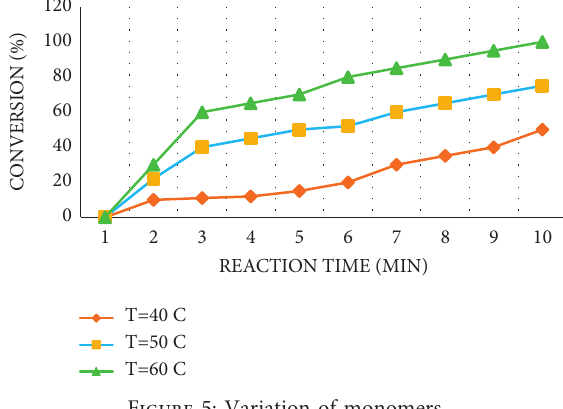
Figure 5: Variation of monomers.